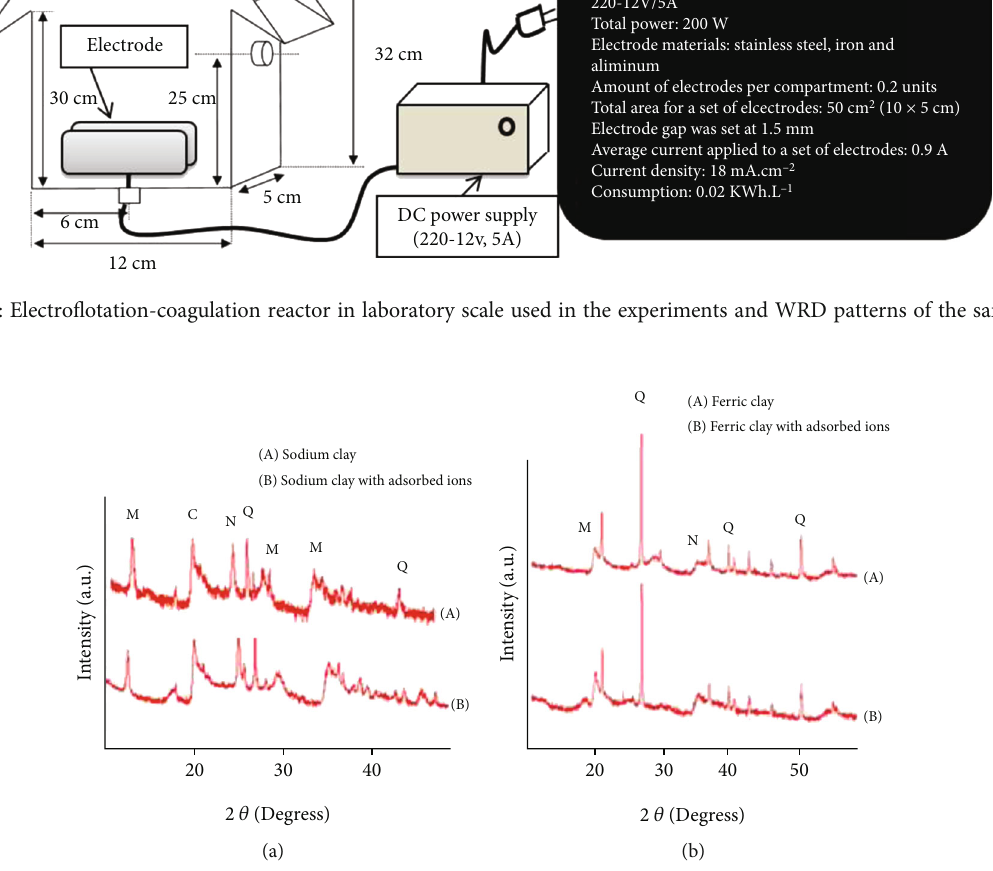
H O Si ), M montmorillonite (Na, Ca), (Al,Mg) 2Si 2 4 9 2